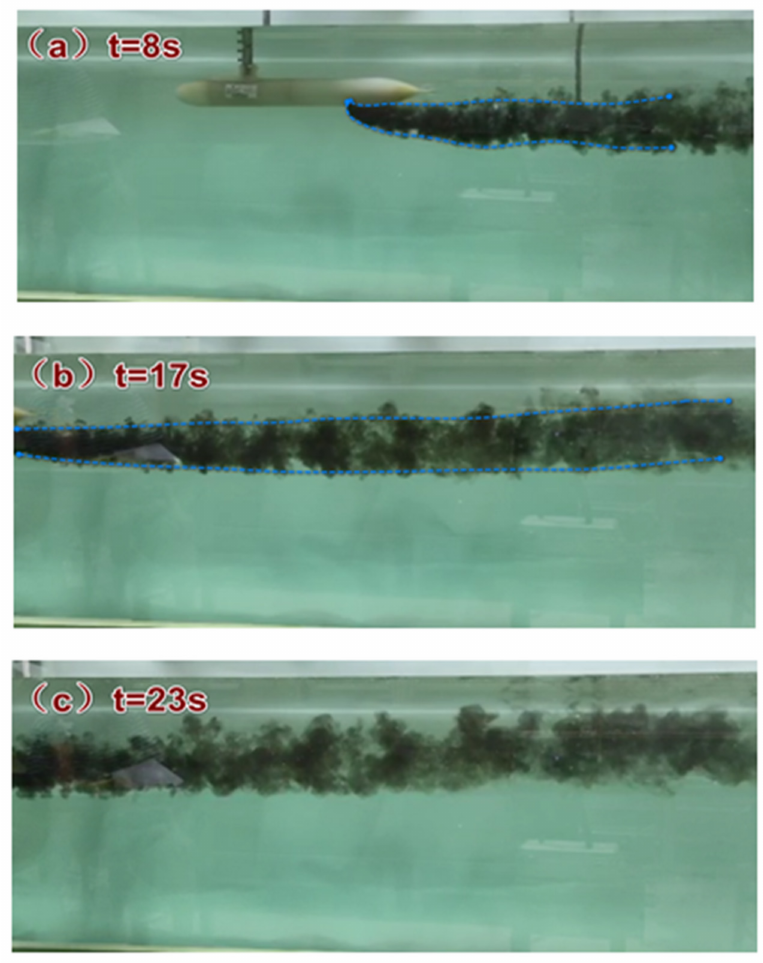
Figure 15. Trajectory of the thermal jet from the circle discharge